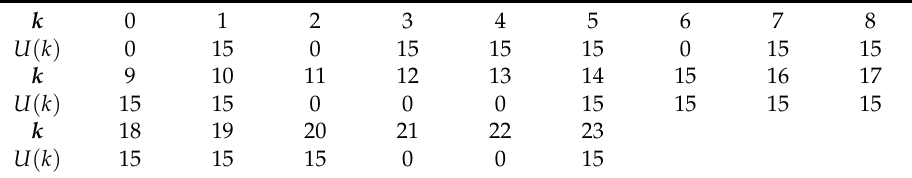
Table 4. Optimal production plan yielded by the Nelder–Mead